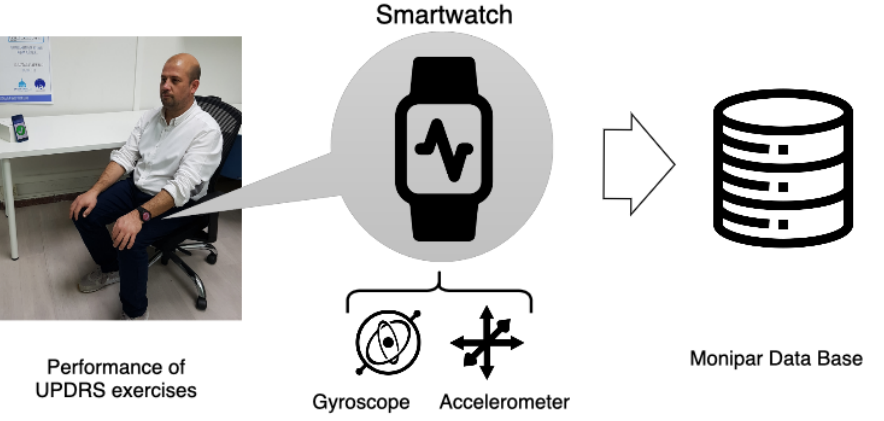
Figure 1. Data collection methodology to detect bradykinesia using smartwatches and MDS- UPDRS exercises.